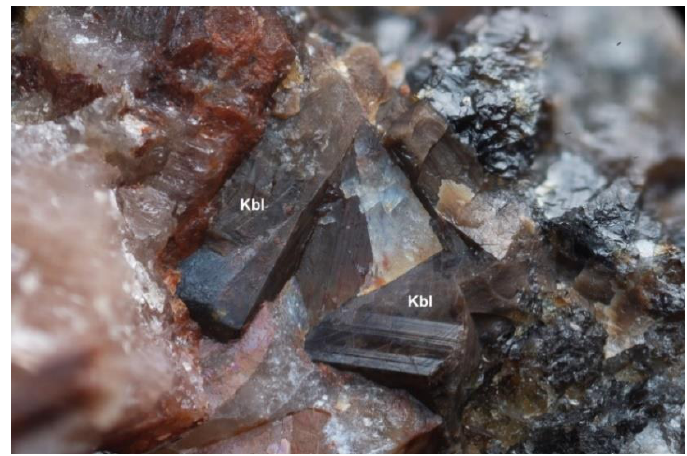
Figure 1. The kesebolite-(Ce) (Kbl) type specimen with calcite (white) and rhodonite (reddish), GEO-NRM No. 20100343. Field of view is ca. 5 × 3 mm. Photo: Torbjörn Lorin.